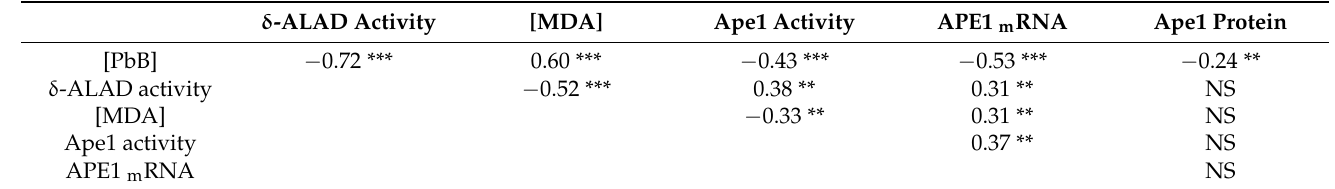
Table 5. Pearson’s correlation coefficient ( r ) between oxidative markers of lead exposure and different Ape1 parameters in workers at a battery recycling